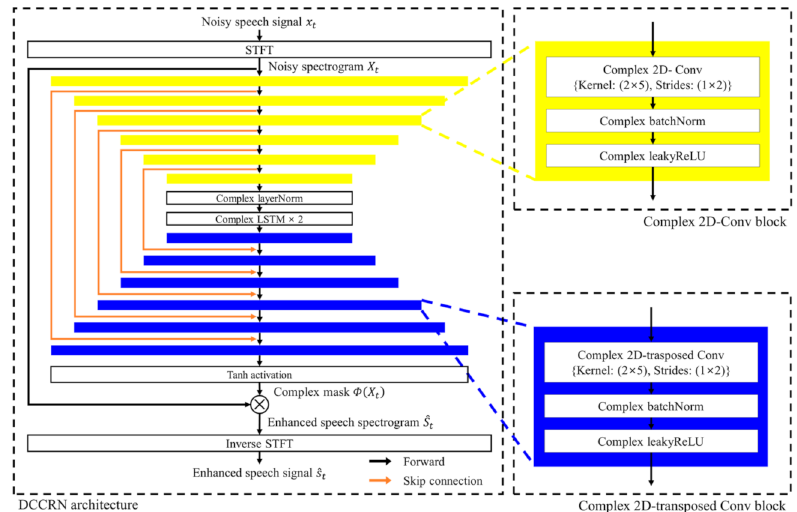
Figure 1. Architecture of the deep complex convolution recurrent network (DCCRN)-based speech enhancement, where ⊕ is the component-wise vector multiplication operator [30].